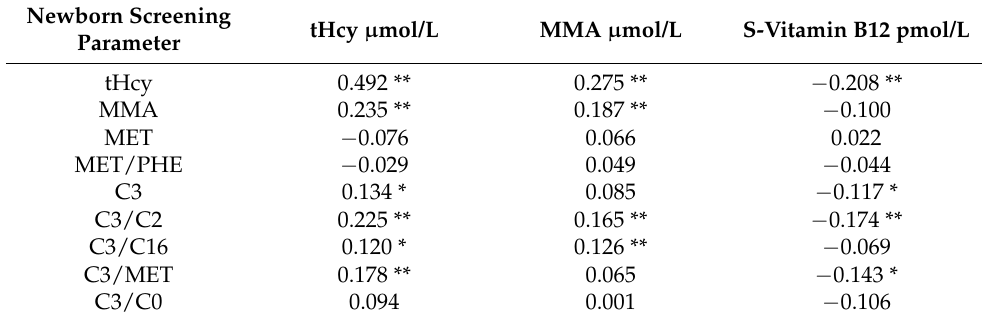
Table 5. Univariate correlations between tHcy, MMA, B12 at mean (SD) 19 (7.4) weeks of age